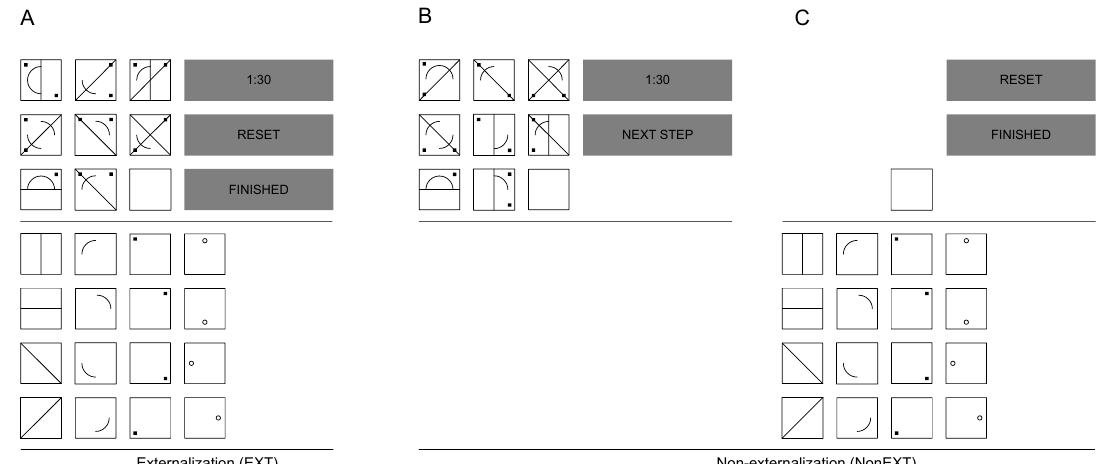
Figure 2. Illustration of the two versions of matrices tests (E XT and N ON E XT ). ( A ) E XT with possibility of immediate response; ( B ) Inducing step of N ON E XT . No response can be given; ( C ) Responding step of N ON E XT . The matrix disappears directly after confirming next step in (B). For better understanding, control button descriptions were translated from German to English for this article.